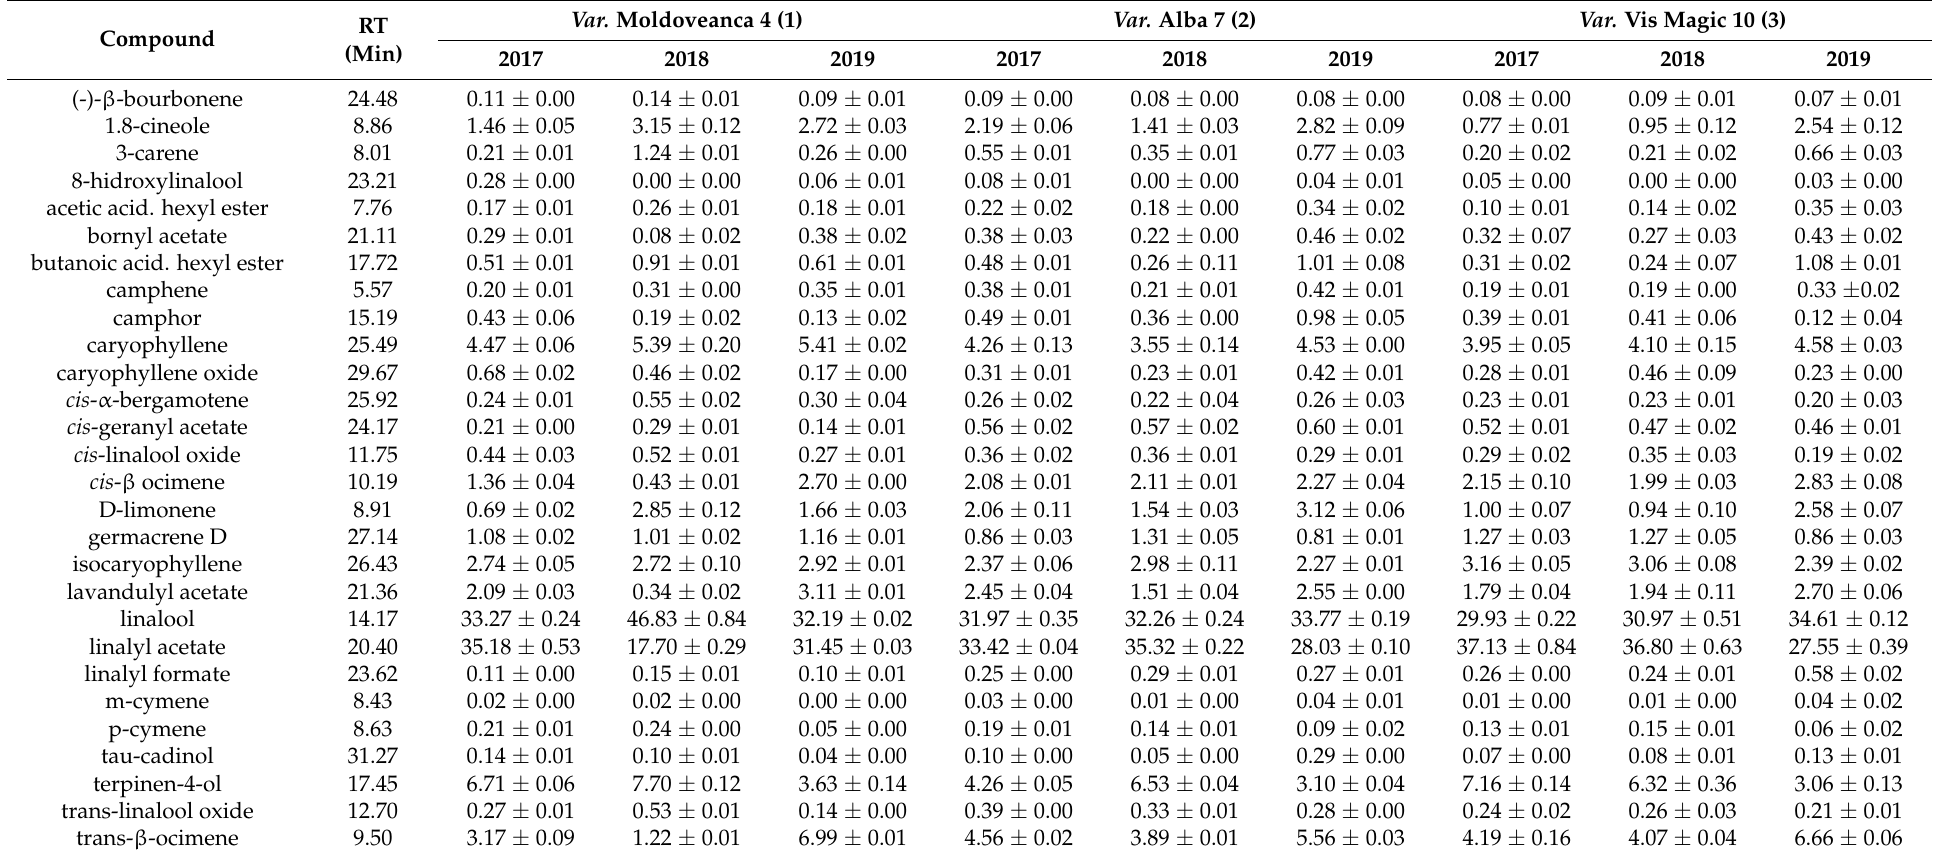
Table 1. Chemical composition of the 3 varieties of L. angustifolia : a. Moldoveanca 4, b. Alba 7, and c. Vis magic 10 essential oils, obtained in 3 consequtive years: 2017, 2018, 2019.